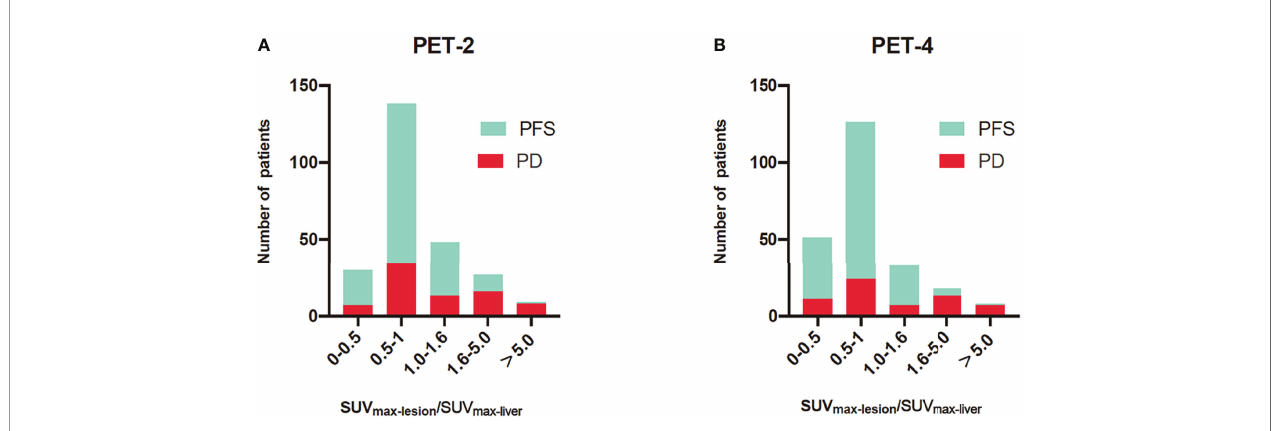
FIGURE 3 | Histograms of SUV max-lesion /SUV max-liver for progression-free survival (PFS) and progression disease (PD) in PET after two cycles of therapy (PET-2) (A) and PET after four cycles of therapy (PET-4) (B) . The SUV max-lesion /SUV max-liver was SUV max ratio between the tumor and liver. For PET-2 and PET-4, interim PET was evaluated by 1.6-fold of SUV max -liver in the Peking criteria and 1.0-fold of SUV max-liver in Deauville 5-point scales. The Peking criteria was better than 5-PS in distinguishing false positive